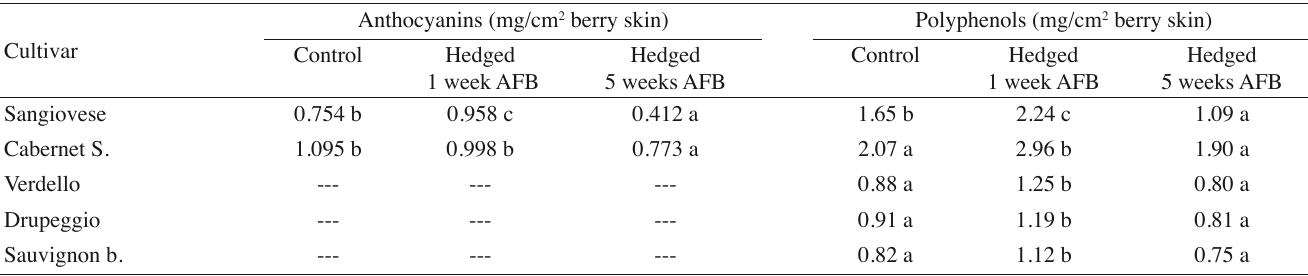
Table 8 - Anthocyanins and total polyphenol content at harvest in the berry skin of different grapevine cultivars hedged one and five weeks after full bloom (AFB) and control